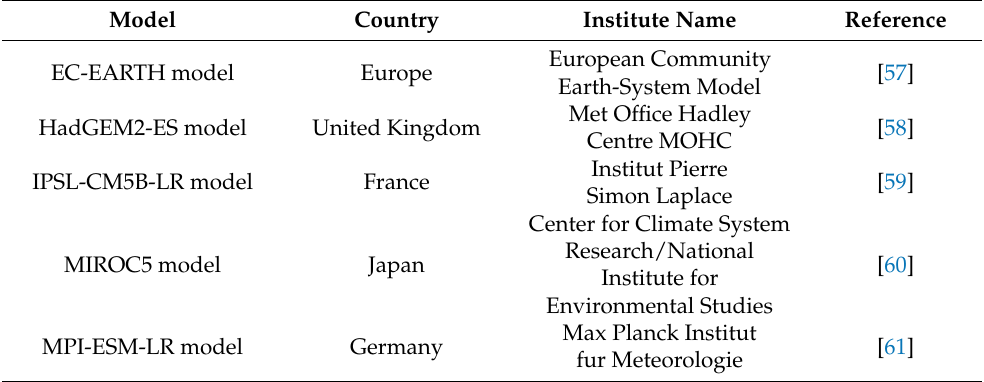
Table 1. Description of the five global circulation models selected for analysis of droughts in this